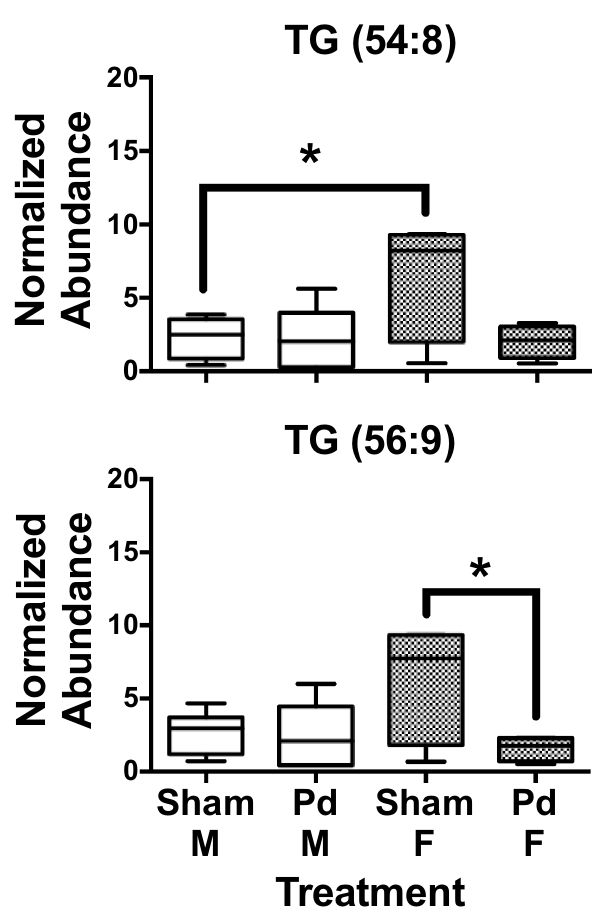
Figure 4. Box and whisker plots of hepatic TG concentrations in Myotis lucifugus . As observed in Eptesicus fuscus , TG concentrations tend to be higher in hibernating females compared to males. TG levels tend to decrease in females with Pseudogymnoascus destructans (Pd) infection compared to the sham treatment with a high effect size observed in TG (56:9) (54:8) and (56:7). * P ≤ 0.05 determined by a one-way ANOVA with multiple comparisons test, lines from top to bottom represent max value, 75th percentile, median, 25th percentile, min value, n = 6 except Pd-infected M. lucifugus ♀ n =